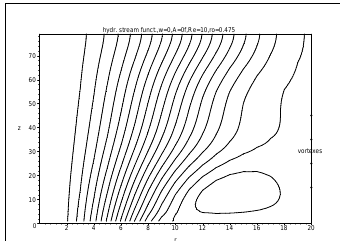
Figure 1. The distribution of pres- sure on an axis in smooth pipe A = 0 .